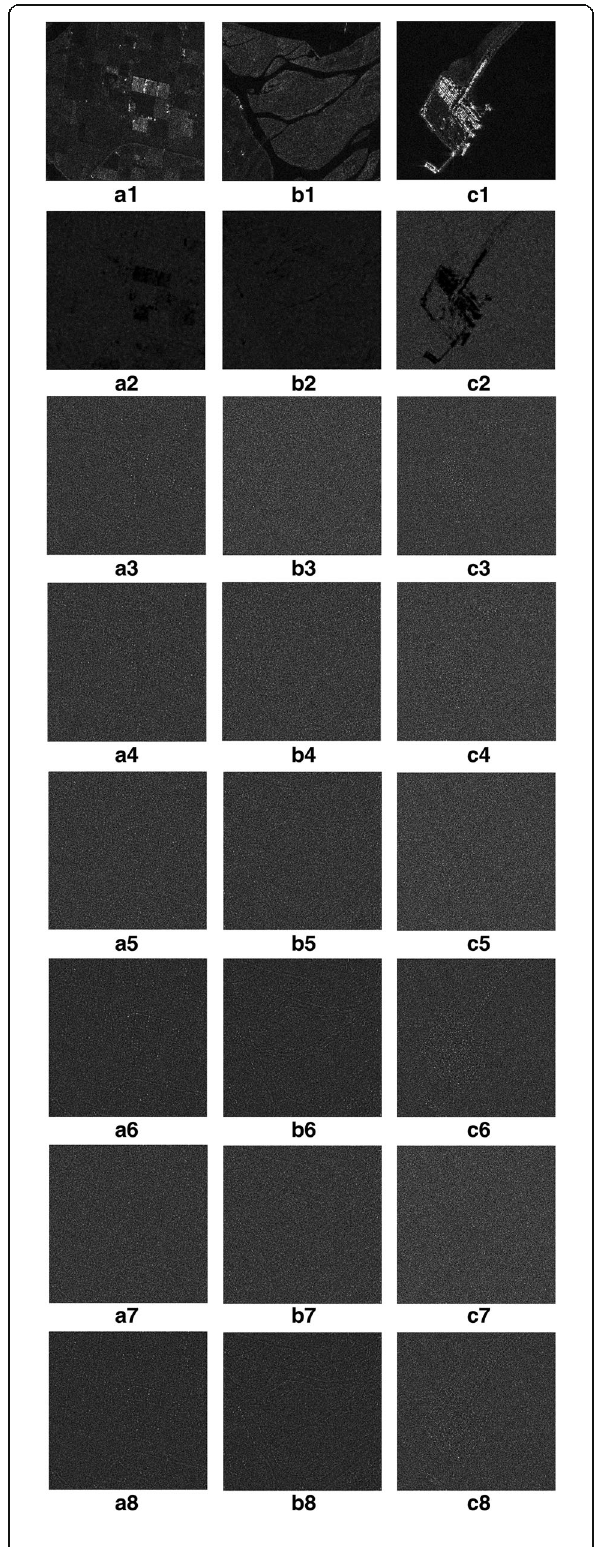
Fig. 11 Real SAR images called Farmland, Peninsula, and Shipping Terminal are shown on the first row, ratio images of the results for High-TV [15], G Γ D ‐ NSST [13], NIG ‐ NSST [13], our proposed methods, BI-NSST(1), WBI-NSST(1), BI-NSST(2), and WBI-NSST(2) are shown in order from rows 2 to